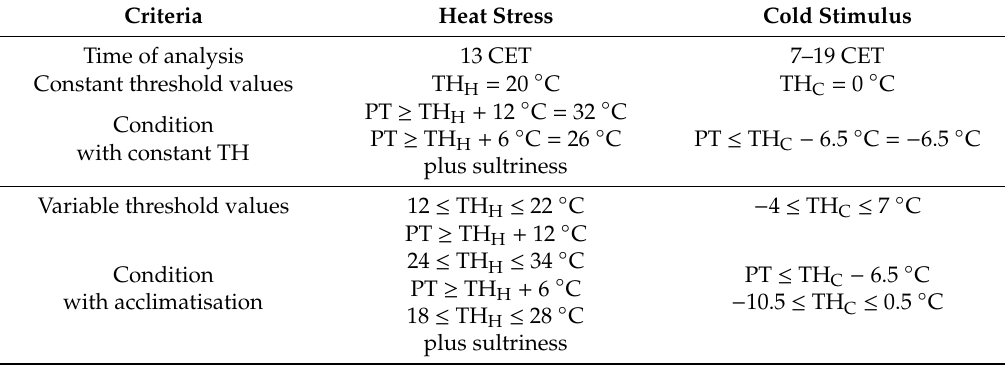
Table 2. Criteria of calculating days with heat stress or cold stimulus, both with constant and variable threshold values. TH, threshold value; THH, threshold value to heat stress; THC, threshold value to cold stimulus; CET, Central European Time.